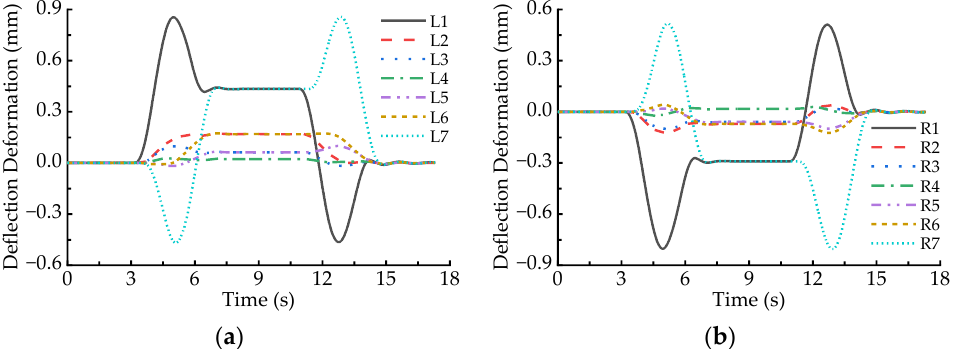
Figure 9. Deflection deformation of the LMs passing through the 650 m radius curve at the speed of 130 km/h: ( a ) L1~L7; ( b ) R1~R7.